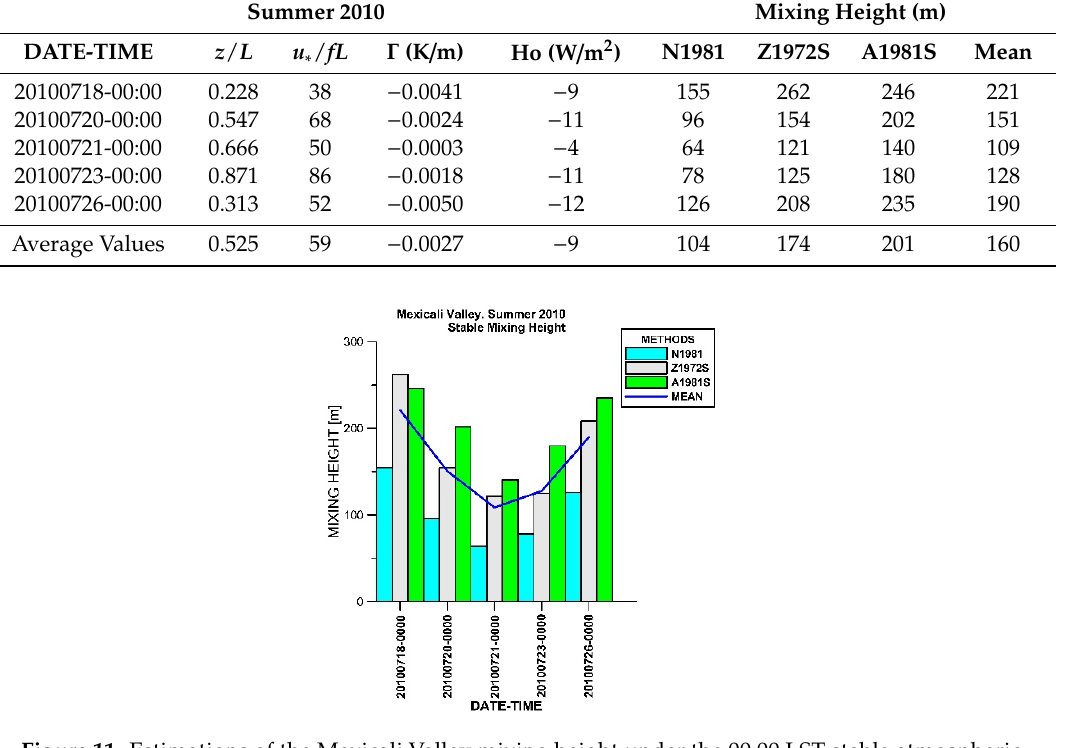
Figure 11. Estimations of the Mexicali Valley mixing height under the 00:00 LST stable atmospheric conditions during the summer 2010 campaign. We observe that the A1981S parametrization, Equation (17), overestimated the mixing height in comparison with the other two models during very stable conditions (μ > 50).